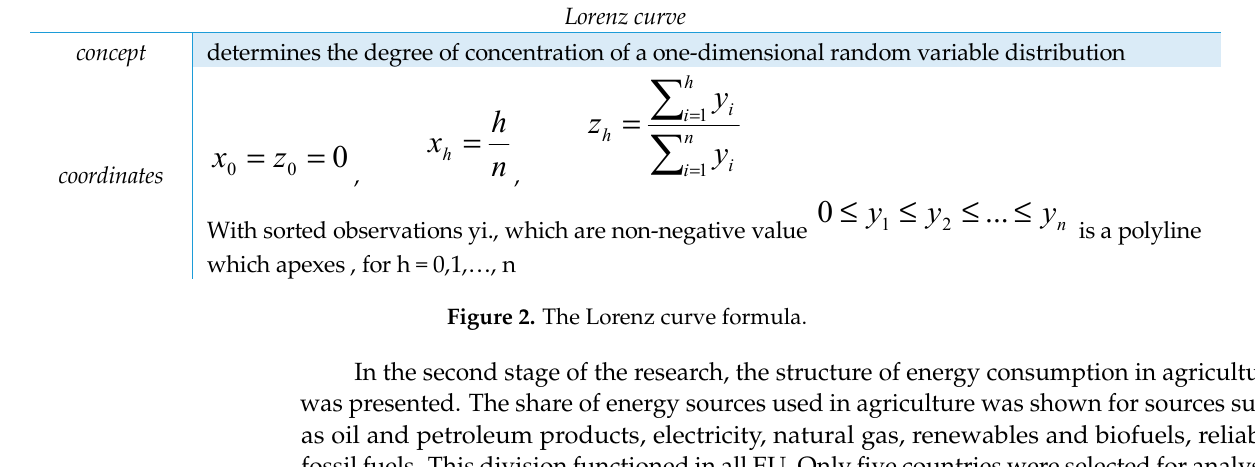
Figure 2. The Lorenz curve formula. Figure 2 . The Lorenz curve formula .